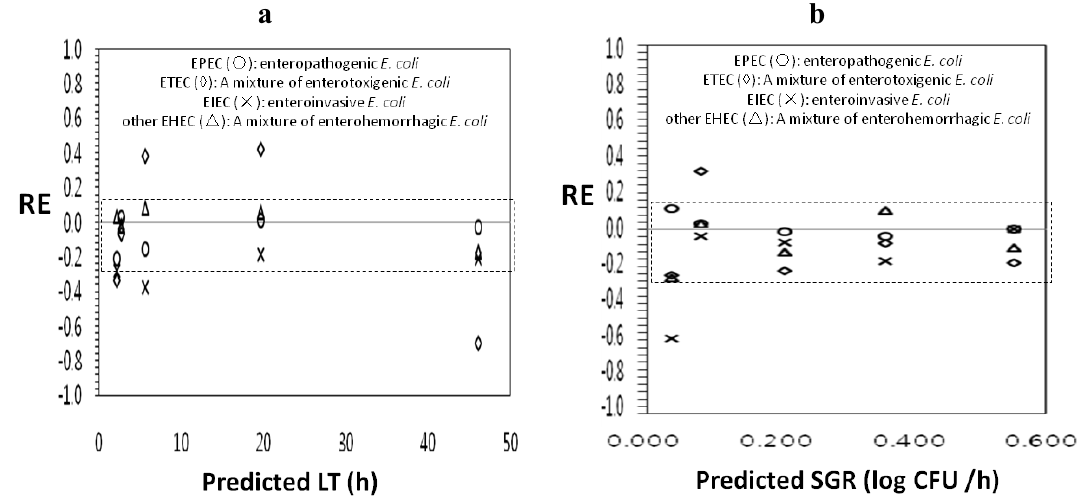
Figure 1. Relative error (RE) plots with an acceptable prediction zone of lag time (LT) and specific growth rate (SGR) data used for model performance of extrapolation. ( a ) LT; ( b ) SGR. a